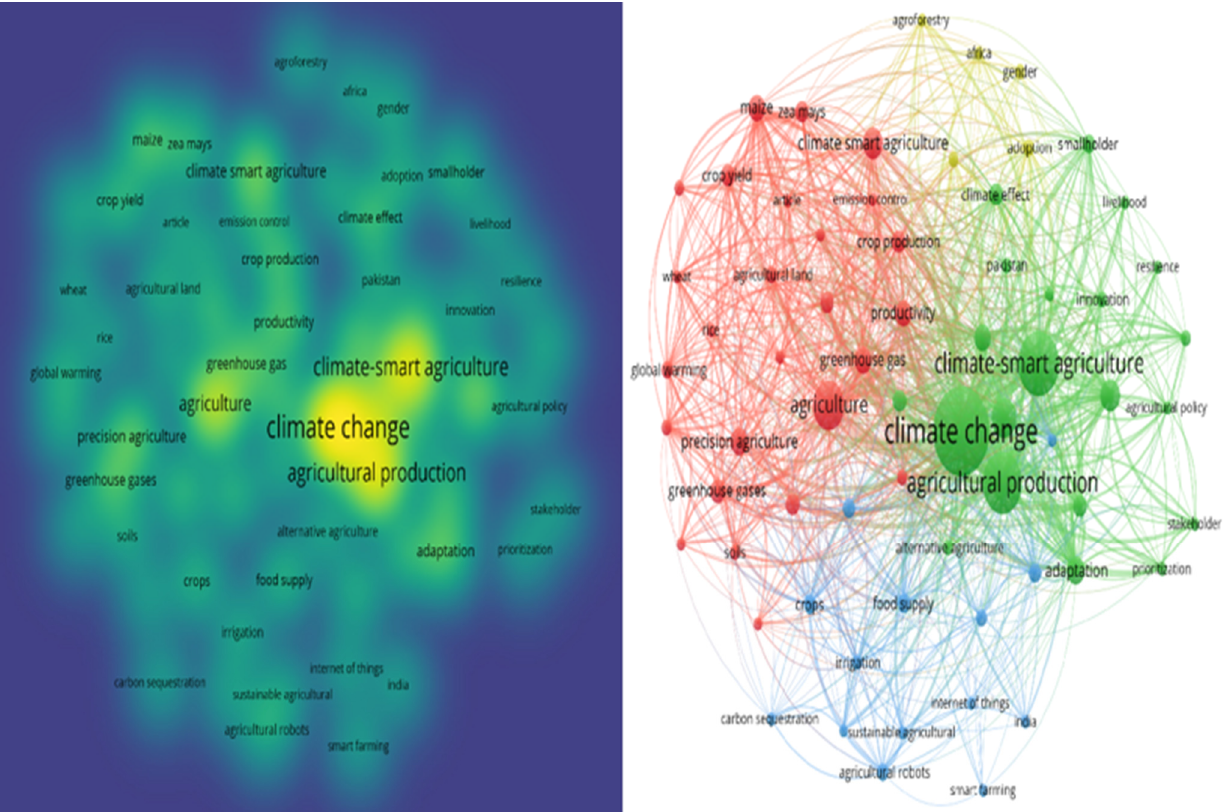
Figure 6. Density and network visualization of co-occurrence of author keywords within the period 2009–2022.